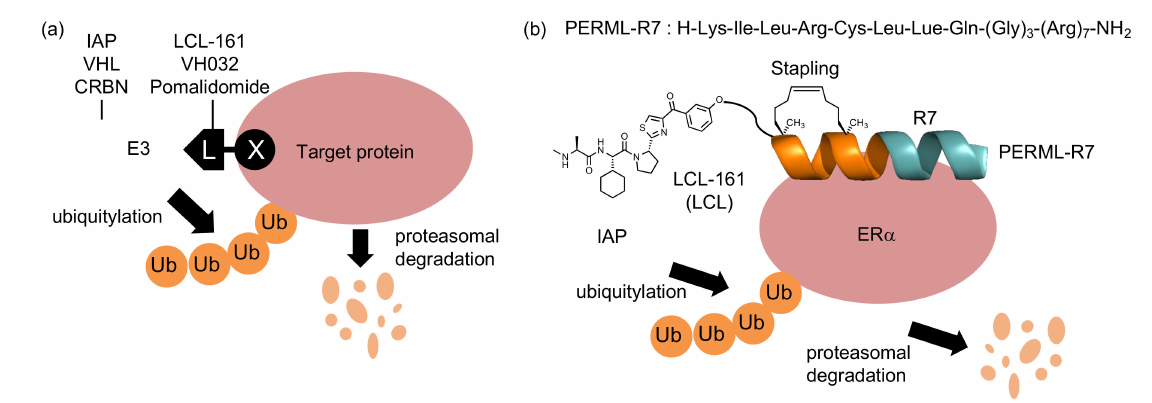
Figure 1. Protein knockdown by small molecule-based and peptide-based PROTACs and SNIPERs ( a ) The mechanism of protein knockdown by PROTACs and SNIPERs. ( b ) Schematic showing targeted protein (ER α ) degradation using SNIPER based on PERML-R7. Abbreviation: ER α ; estrogen receptor α , Ub; ubiquitin, IAP; inhibitor of apoptosis protein, VHL; von Hippel-Lindau, CRBN;